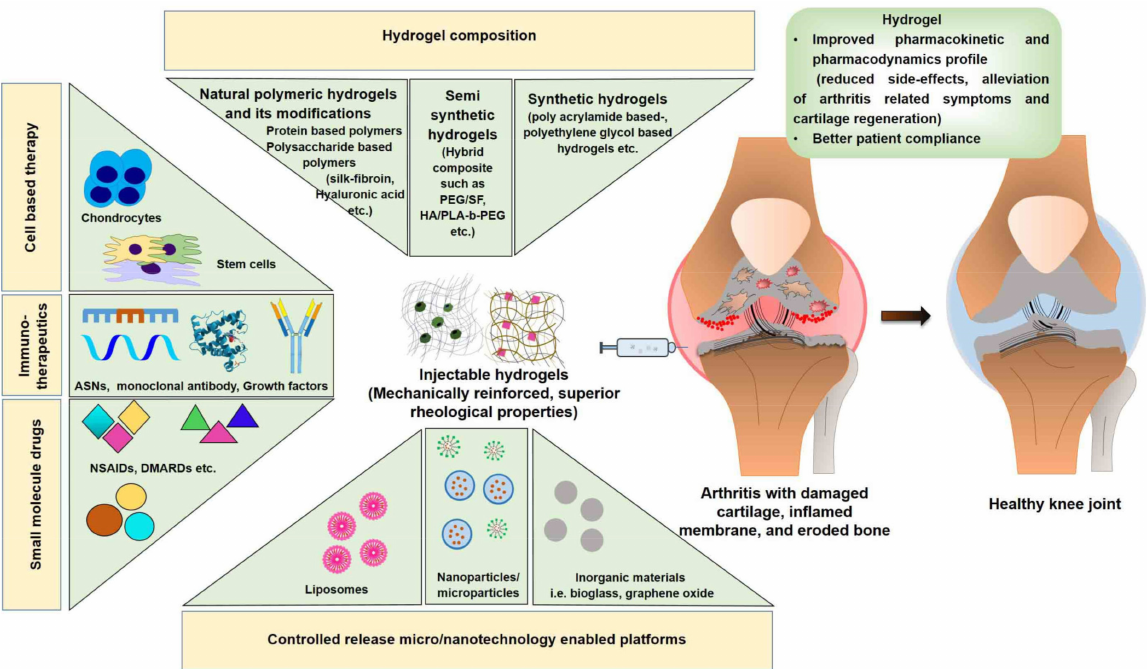
Figure 1. Overview of polymeric hydrogels used to deliver small molecule drugs, immunotherapeu- tics, and cells to joint sites for alleviating pain, swelling, inflammation, thus providing viscoelastic, lubrication, and cartilage repair